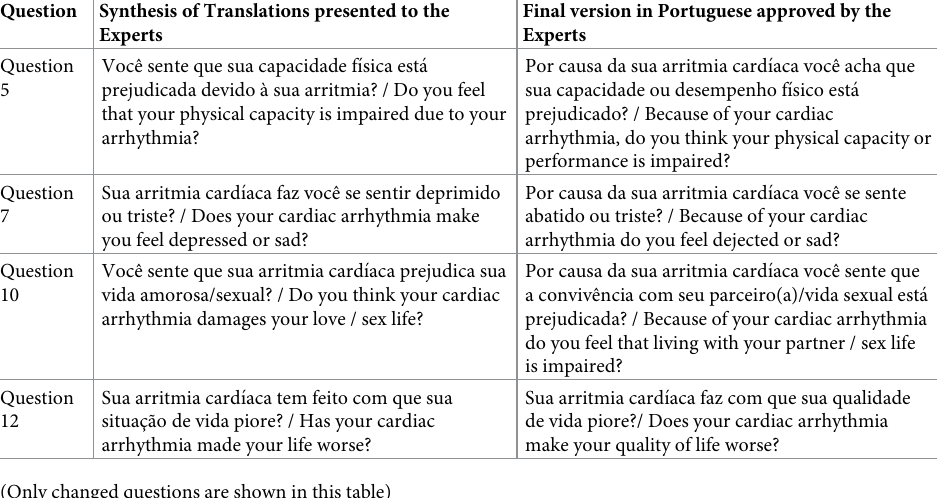
Table 1. Comparisons between the syntheses of the translations presented to the experts and the final version of the ASTA-Br-HRQOL. Question Synthesis of Translations presented to the